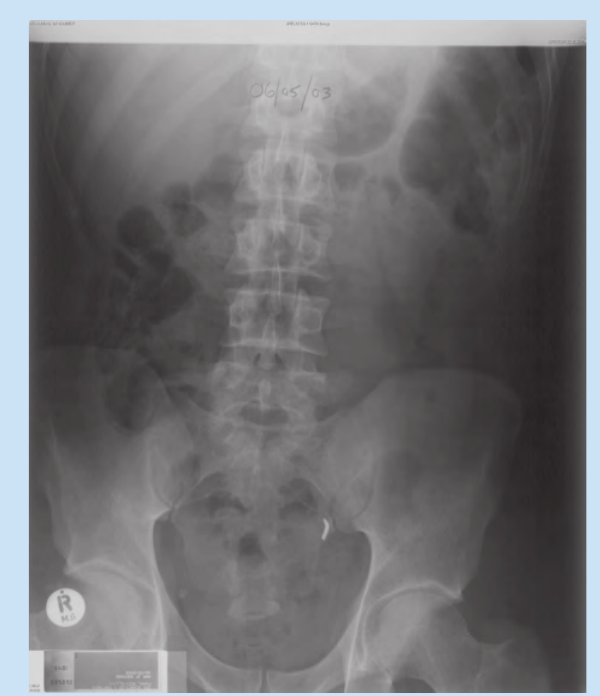
Fig. 1. X-ray of 2003 shows a metal foreign body in the pelvis.